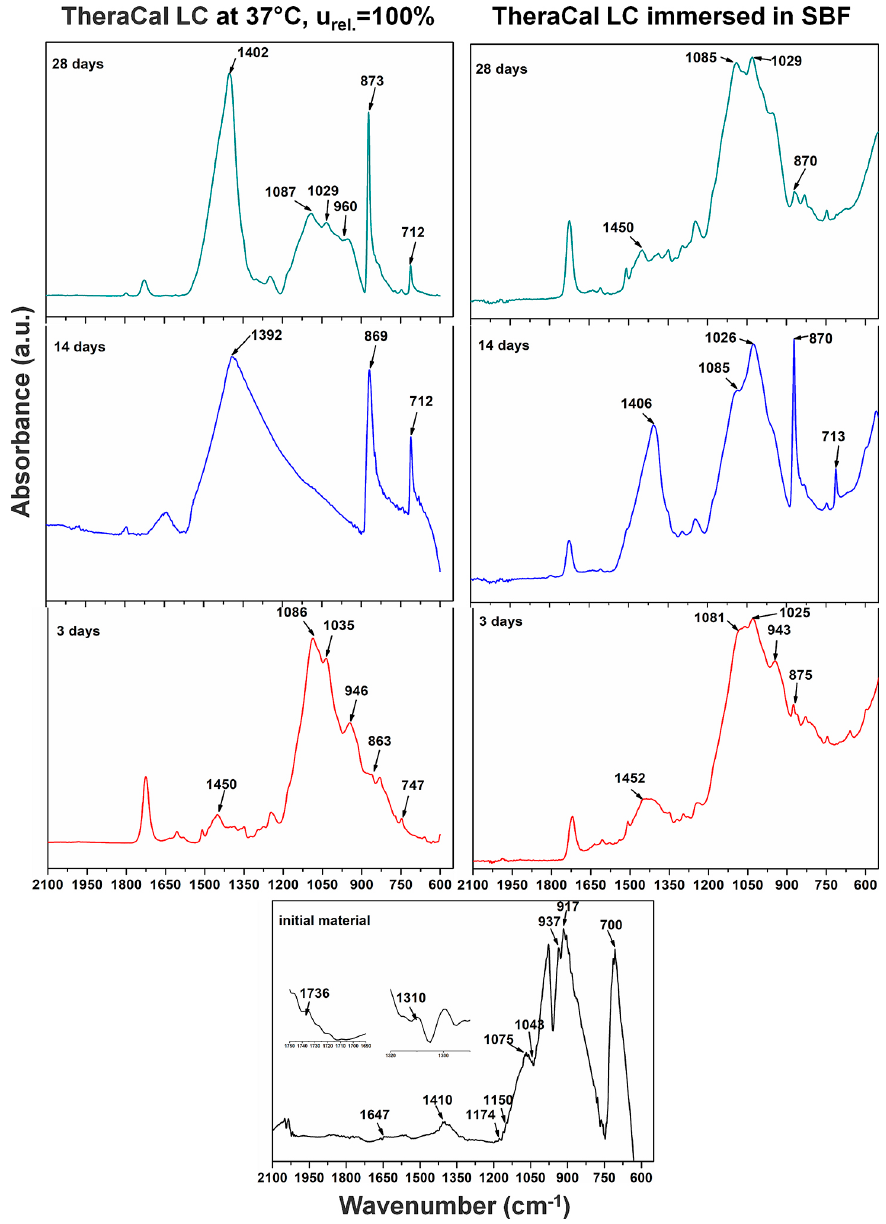
Figure 10. FT-IR spectra for TheraCal, and immersion in SBF (simulated body fluid) .